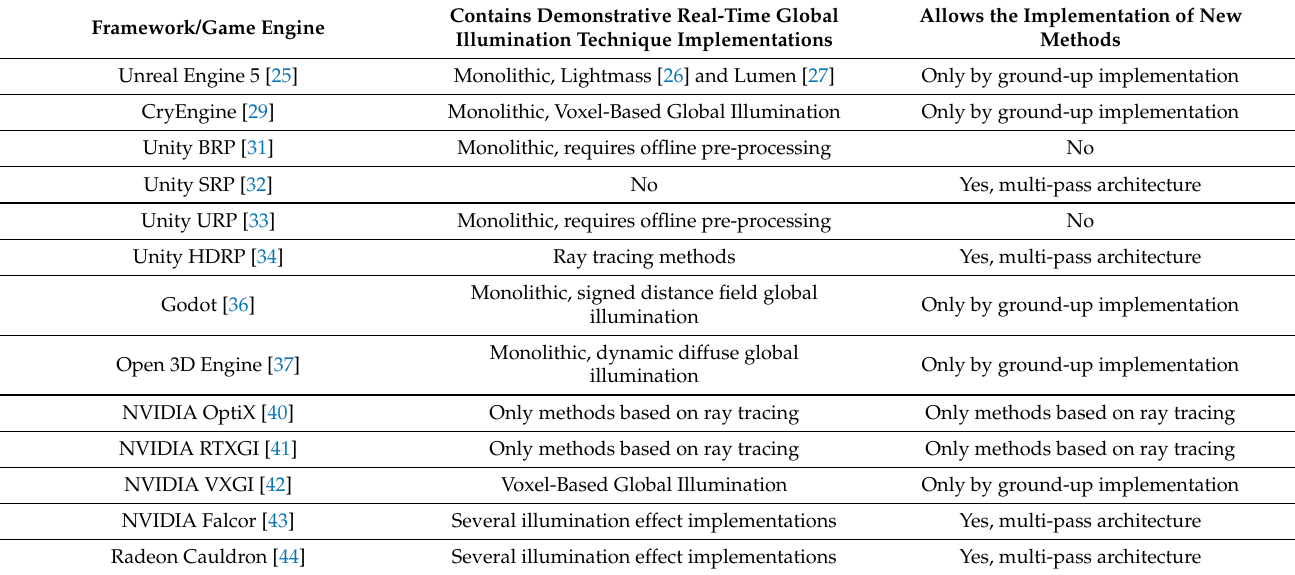
Table 2. Comparison between the frameworks and game engines for real-time global illumination im-